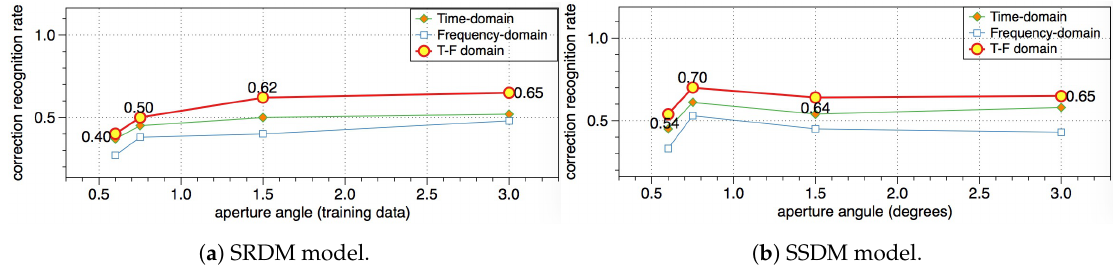
Figure 11. Test results of four sets of single-domain HRRP data in SRDM and SSDM models